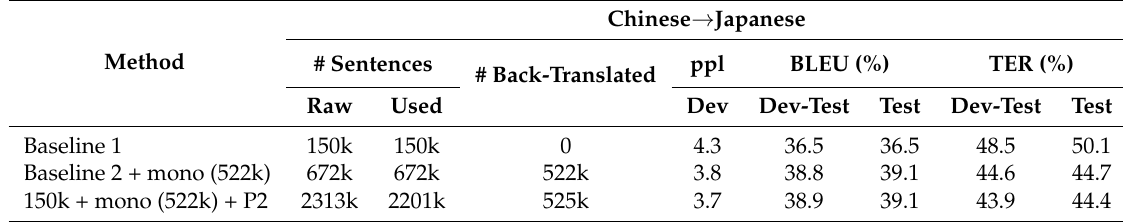
Table 6. Experiment results of Japanese → Chinese MT with 150k sentences and 522k monolingual sentences. “ppl” denotes perplexity. “Dev” denotes development data. “Dev-test” denotes development-test data.